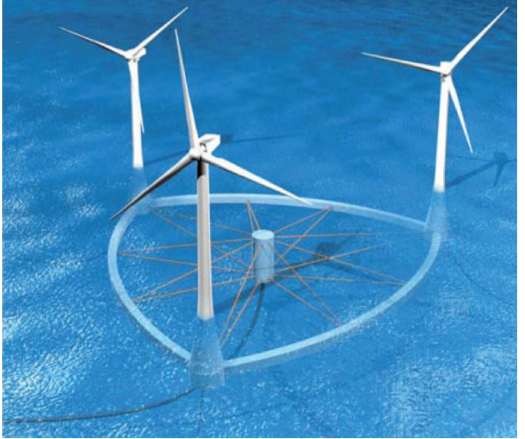
Figure 7. Semi-submersible offshore floating wind turbine; Reprint with permission [81]; 2007, ICWE12